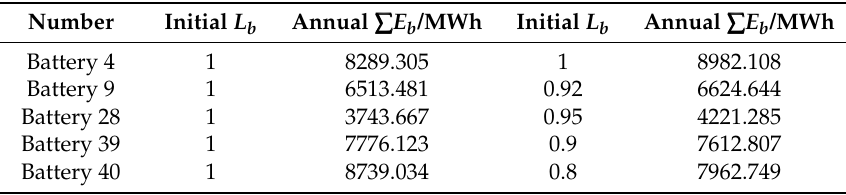
Table 7. Results of Case